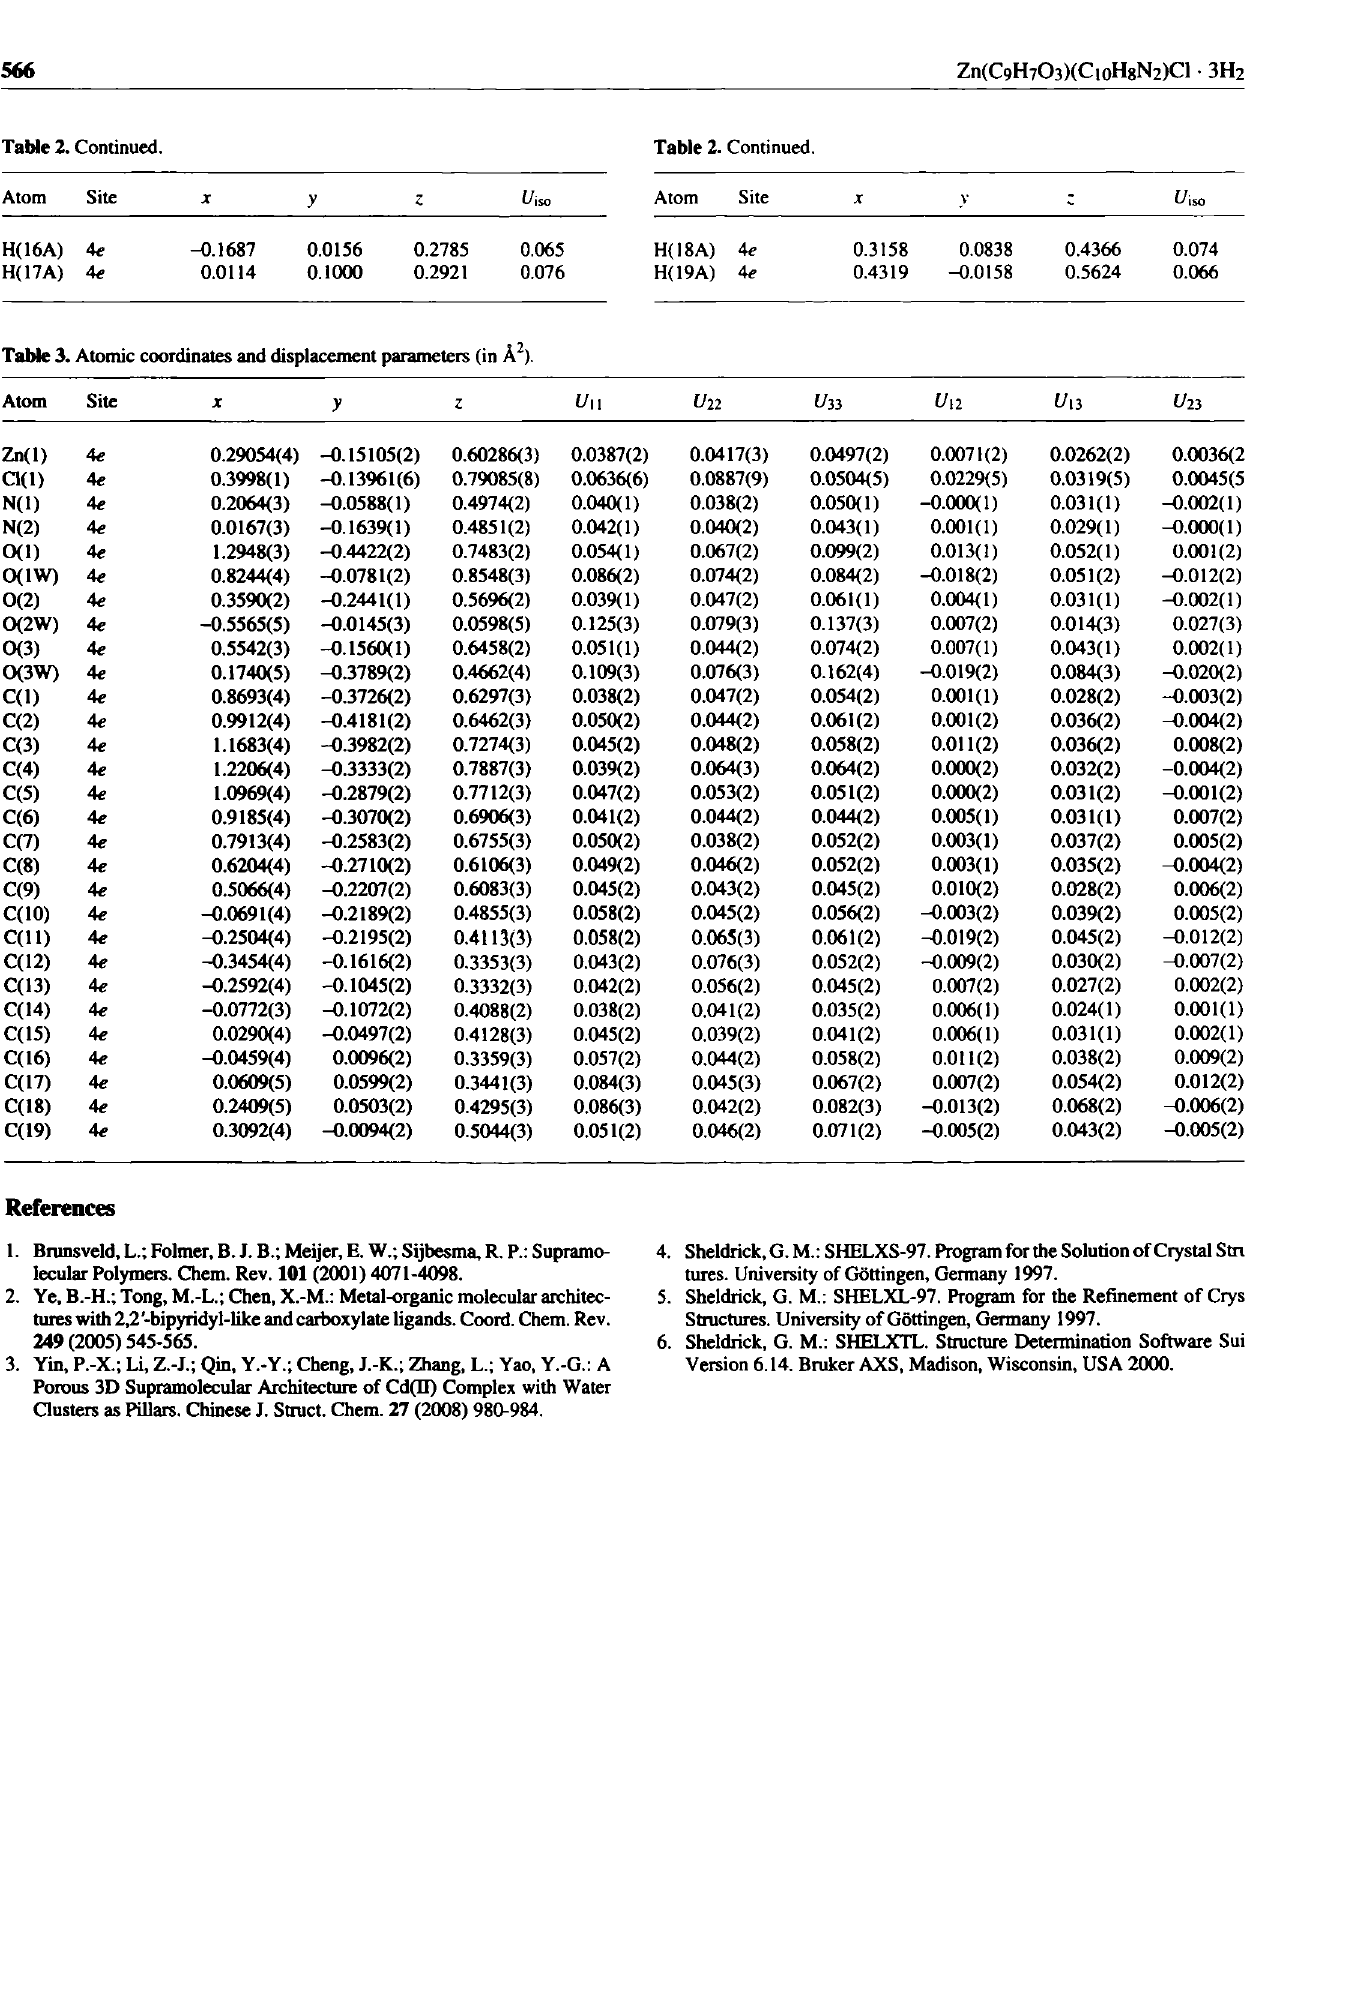
Table 3. Atomic coordinates and displacement parameters (in À 2